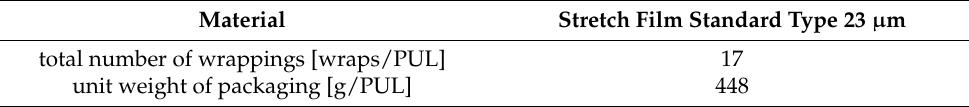
Table 3. Parameters of cargo application with standard film.